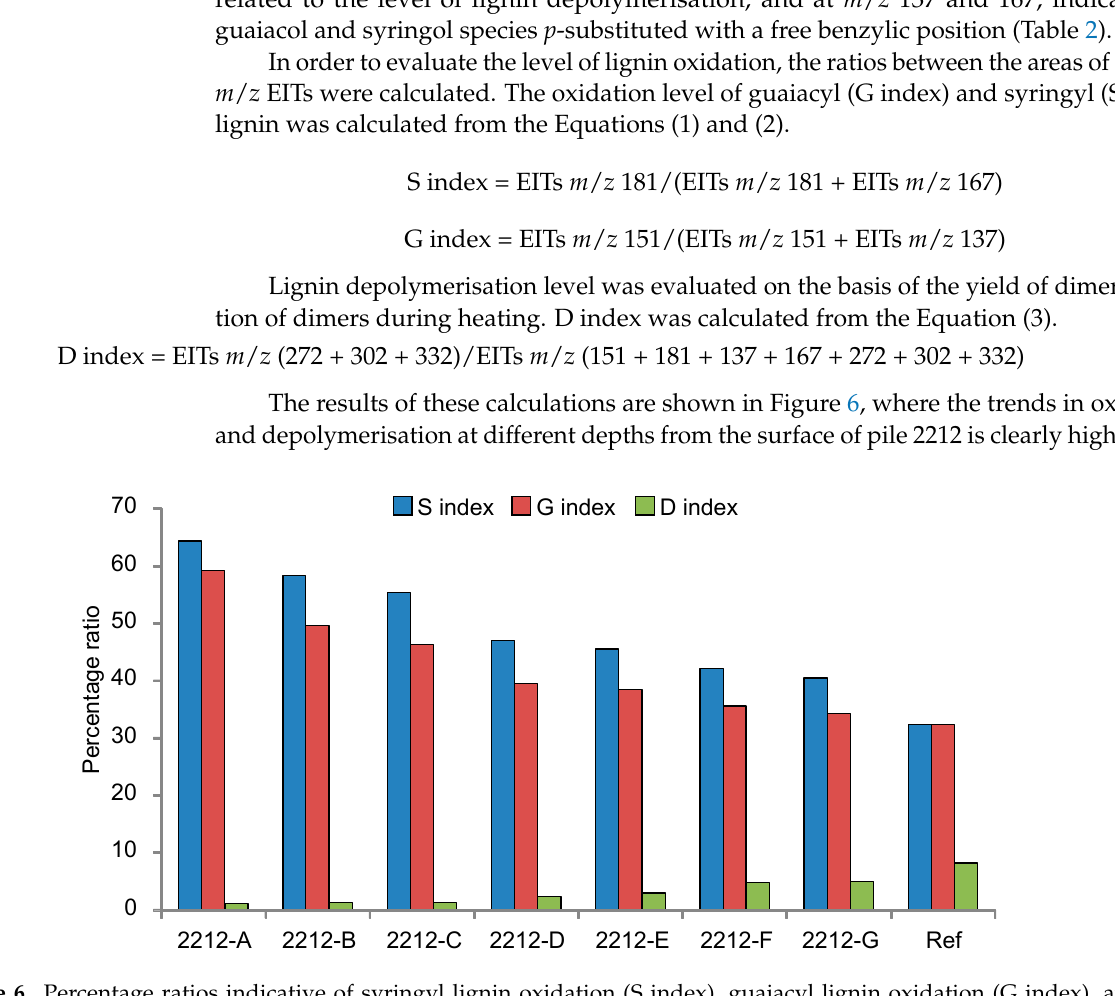
Figure 6. Percentage ratios indicative of syringyl lignin oxidation (S index), guaiacyl lignin oxidation (G index), and formation of dimers (D index) in EGA-MS analysis of the wood pile 2212 from La Marmotta site at different depths from the surface, where A—surface, G—core, Ref—reference, (sound non-degraded oak wood sample).